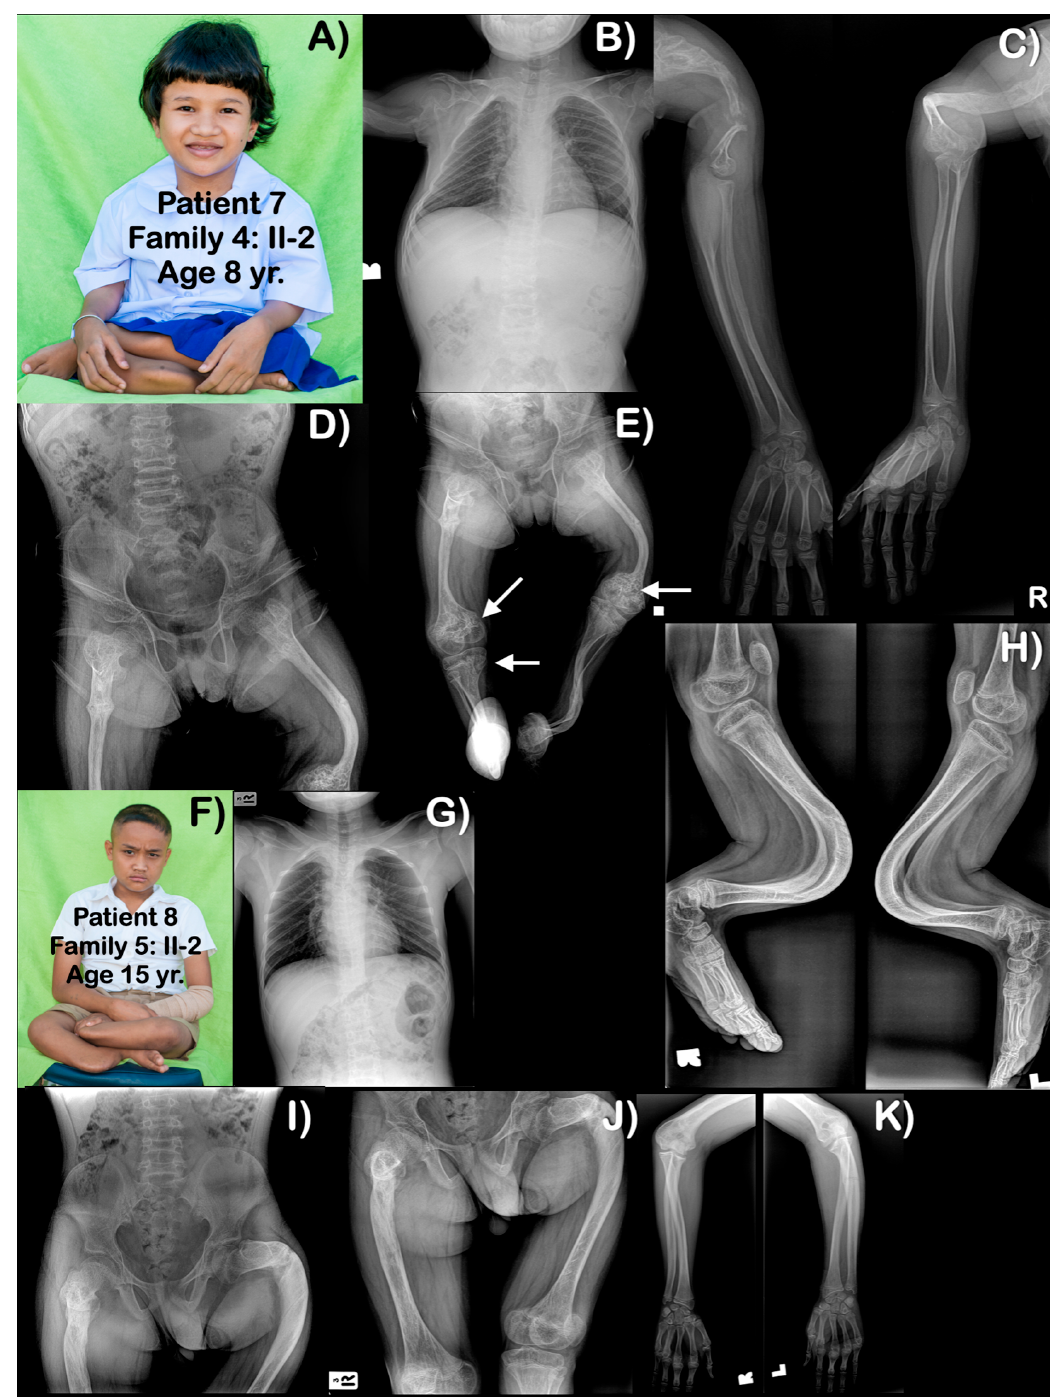
Figure 5. (A – E ) Family 4 . Patient 7 ( Family 4: II - 2 ). Age 8 years . Generalized osteopenia is evident . Figure 5. ( A – E ) Family 4. Patient 7 (Family 4: II-2). Age 8 years. Generalized osteopenia is evident. All long bones are slender , with humeri, femora, and tibiae severely shortened and curved . Proxi- All long bones are slender, with humeri, femora, and tibiae severely shortened and curved. Proximal mal epiphyses and metaphyses of humeri are large . Multiple past fractures of long bones are evi- epiphyses and metaphyses of humeri are large. Multiple past fractures of long bones are evident. dent . (E) Distal femora are bulbous with popcorn calcifications ( arrows ). Right proximal tibia has ( E ) Distal femora are bulbous with popcorn calcifications (arrows). Right proximal tibia has popcorn popcorn calcifications ( arrow ). (F – K) Family 5 . Patient 8 ( Family 5: II - 2 ). Age 15 years . Generalized calcifications (arrow). ( F – K ) Family 5. Patient 8 (Family 5: II-2). Age 15 years. Generalized mild mild osteopenia . Humeri and femora are shortened . Fractured left proximal ulnar is seen. Unlike osteopenia. Humeri and femora are shortened. Fractured left proximal ulnar is seen. Unlike other other patients, long bones are not slender . Femora and left humerus are bowed . Tibiae and fibulae patients, long bones are not slender. Femora and left humerus are bowed. Tibiae and fibulae are are severely bowed anteriorly . Popcorn calcifications are not observed. severely bowed anteriorly. Popcorn calcifications are not